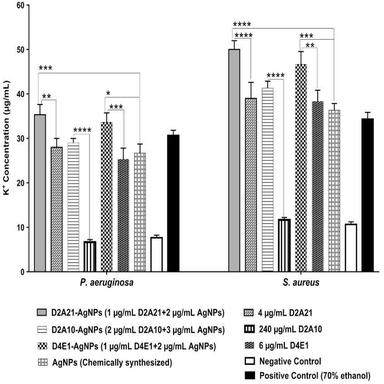
Determination of intracellular K+ leakage from P. aeruginosa and S. aureus after treatment with P-AgNPs, native peptides, and chemically synthesized AgNPs. Positive and Negative controls were maintained as bacterial cell suspensions with 70% ethanol and no drug treatment, respectively. The statistical significance was observed between P-AgNPs and native peptides; P-AgNPs and chemically synthesized AgNPs.